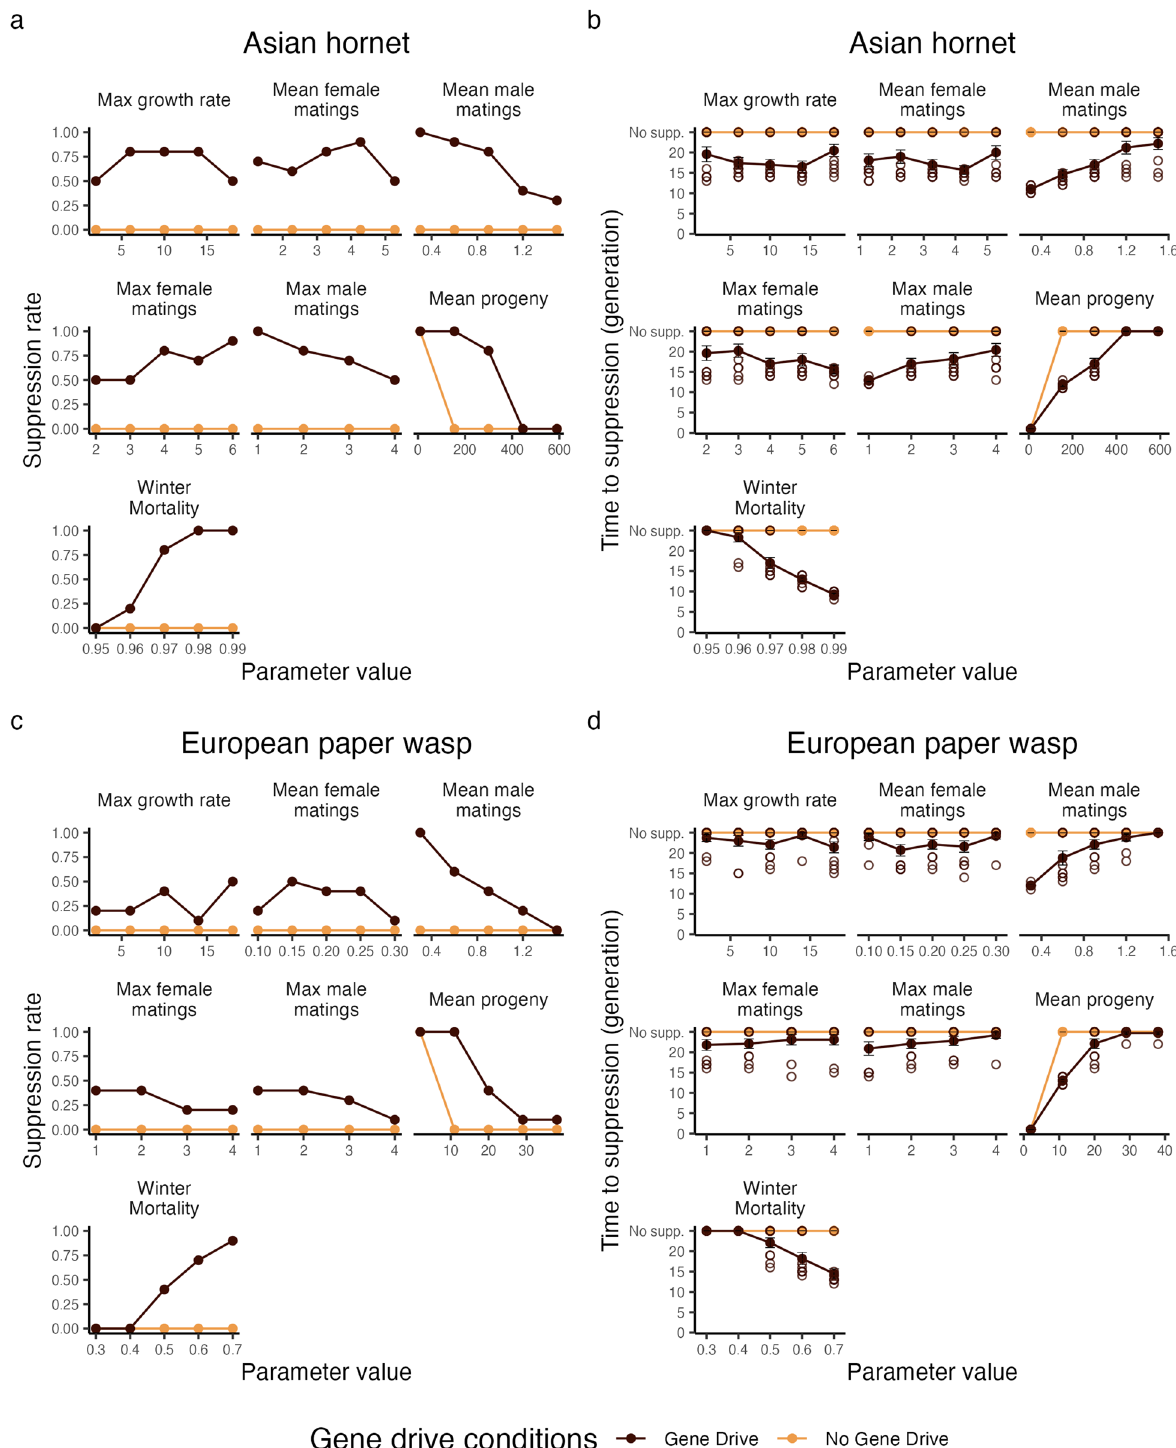
Figure 4. Sensitivity analysis for the biological parameters of the Asian hornet ( a,b ), and the European paper wasp ( c,d ). Panels ( a,c ) show the suppression rate for the gene drive after 25 generations. Panels ( b,d ) show the time required for the gene drive to suppress the population. The open circles indicate the individual repetitions, while the solid circles and the lines show the average time to suppression. The error bars indicate the standard error of the mean. for ( b,d ), no supp. stands for no suppression. In these cases the population was not suppressed after 25